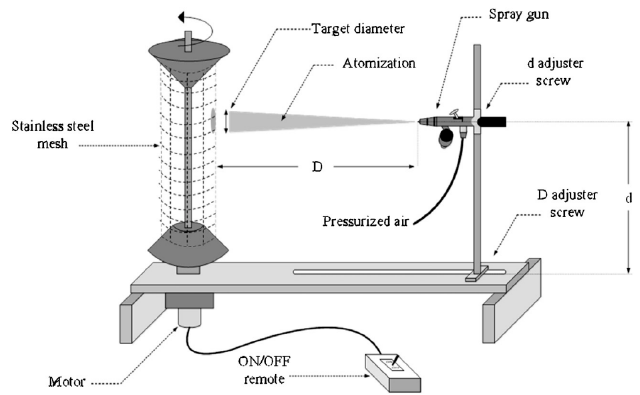
Figure 4. Representation of the automatized spray coating (ASC) system developed by Lugo-Vega et al. (2016) for the TiO 2 -AAS-ASC method